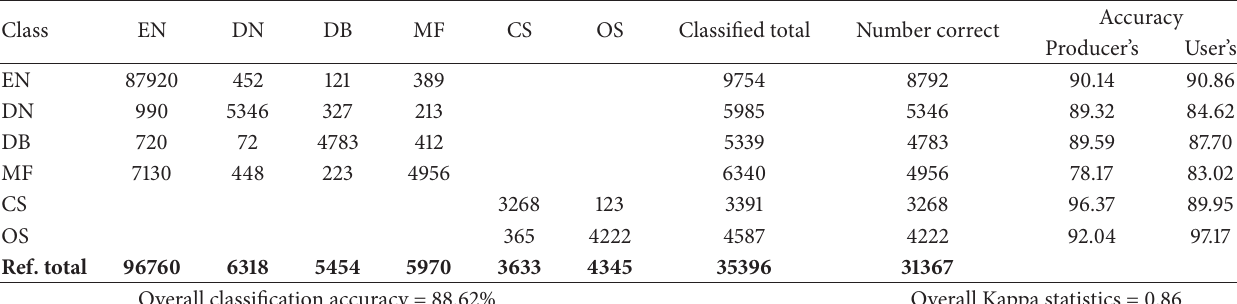
Table 5: The confusion matrix for the vegetation classification from land use type to land covers